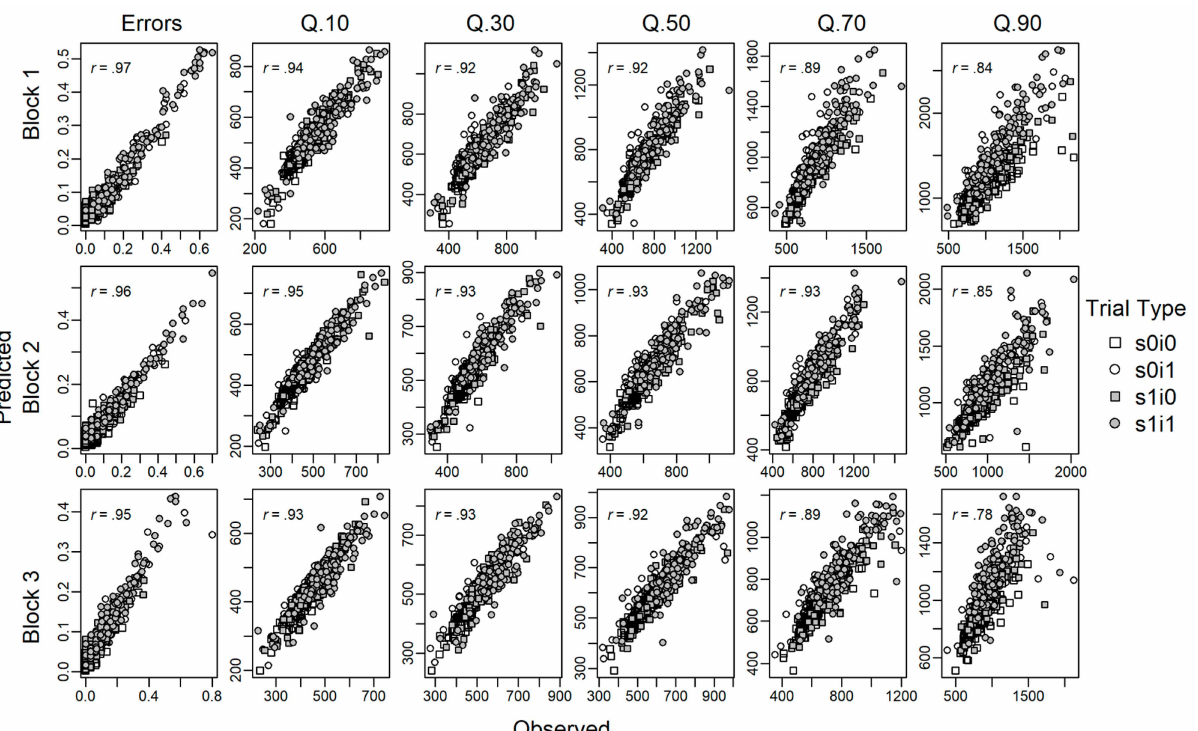
Figure A2. Scatterplot of observed and model-predicted proportion of errors and quantiles of correct responses (in milliseconds) for participants in the respective trial types, as defined by task repeat vs. task-switch (s0; s1) trials with response–congruent vs. incongruent (i0; i1) stimulus